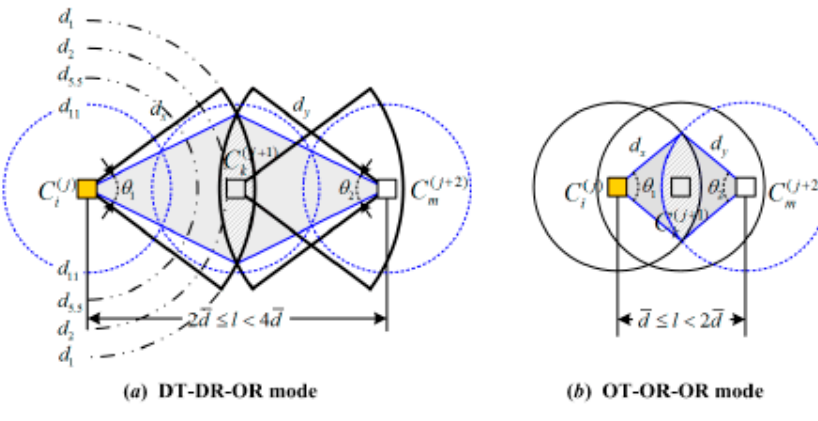
Figure 7. Searching probability region in Scenario 3.